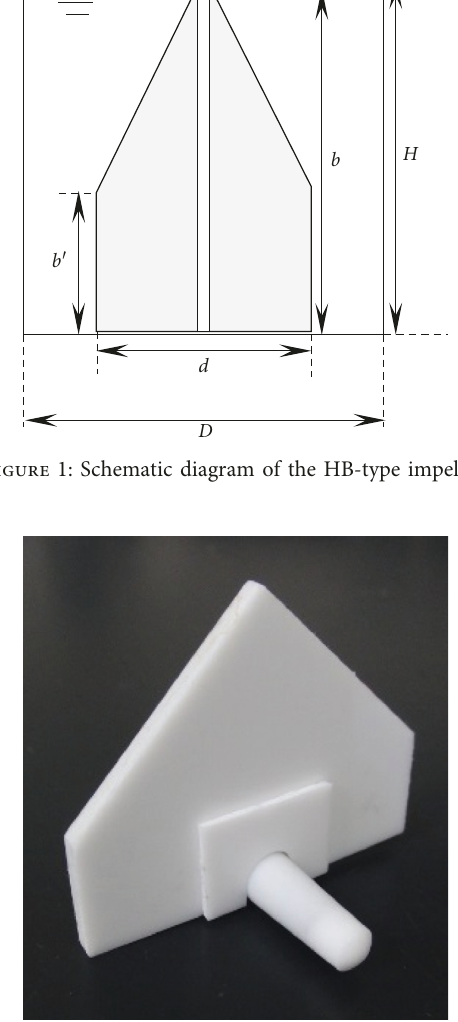
Figure 2: HB-type stirring